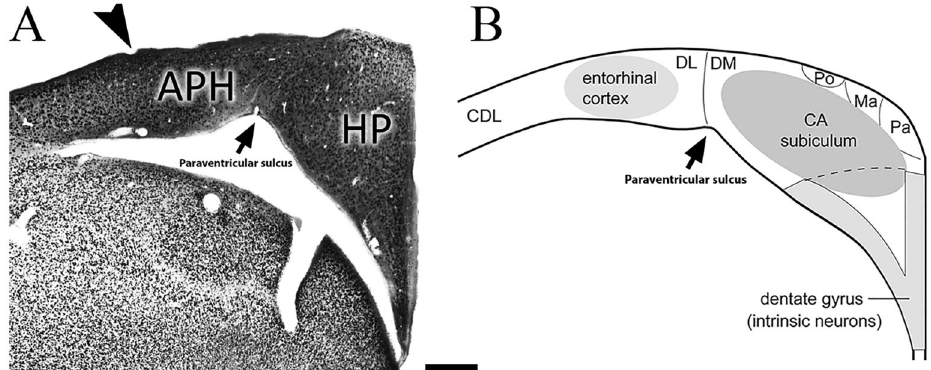
Figure 7. Hypothetical hippocampal homologies of birds and mammals. Left: section of the hippocampal formation of Actitis macularia immunolabeled for NeuN. The arrowhead indicates the lateral limit of the parahippocampal area and the arrow indicates the paraventricular sulcus, which is the lateral boundary of the hippocampus. Right: hypothetical homologies between the subregions of the hippocampal formation in mammals and birds. The ventral V-shape on the right (light gray) is comparable to the mammalian dentate gyrus, the dorsomedial area (DM) is comparable to the horn of Ammon (CA), and the subiculum and the dorsolateral (DL) area are homologous to the entorhinal cortex. Other regions include the histologically distinct magnocellular region (Ma), the parvocellular (Pa) and a region poor in cellular elements (Po). APH: parahippocampal area; Hp: hippocampus. Scale: 500 m m. Adapted from Atoji et al.